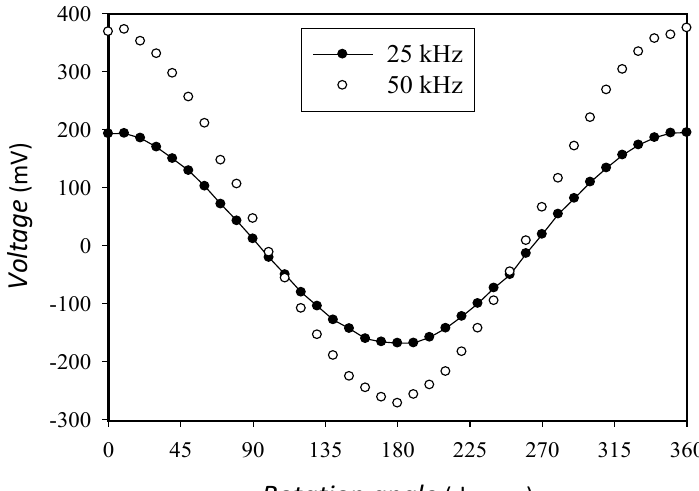
Figure 8. The perfect detection of earth fields as an e-compass at 25 kHz and 50 kHz excitation frequencies using our proposed fluxgate